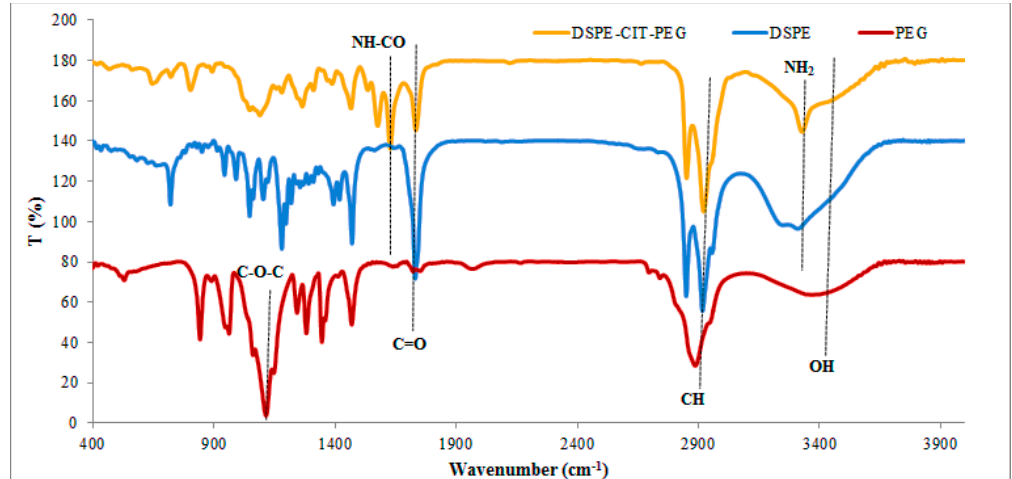
Figure 1. FTIR results of PEG, DSPE, and DSPE ‐ CIT ‐ PEG.